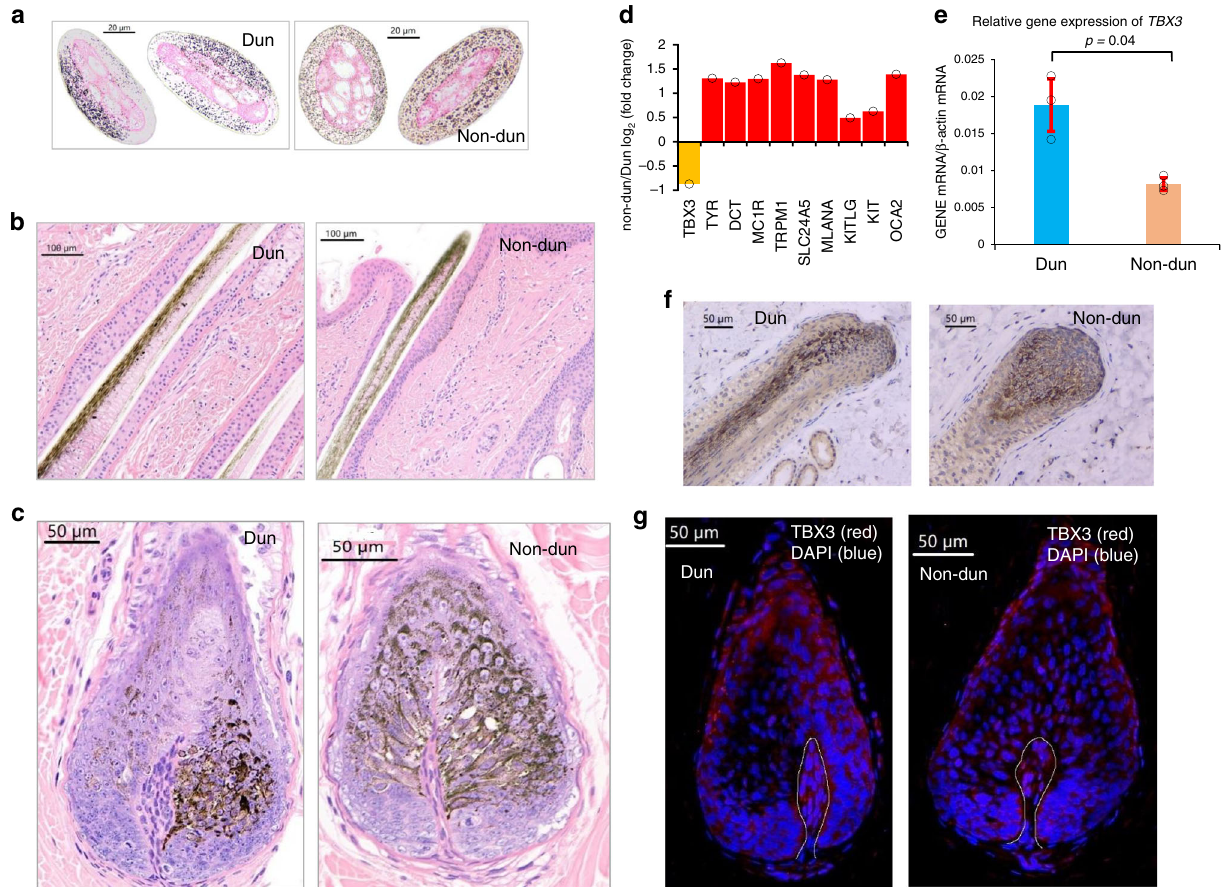
Fig. 4 Phenotypic characterization and differential gene and protein expression in the croup skin of Dun and non-Dun donkeys. a Micrographs of cross- sections of hairs from Dun and non-Dun donkeys, images representative of three experiments b Micrographs of skin and hair sections from Dun and non- Dun donkeys stained with hematoxylin and eosin, images representative of three experiments. c Micrographs of sections of anagen hair follicles from Dun and non-Dun donkeys stained with hematoxylin and eosin, images representative of three experiments. d Bar plot of differential mRNA expression (log 2 - transformed fold change) of 10 pigmentation-related genes expressed in the skin of non-Dun ( n = 3) versus Dun ( n = 3) donkeys. Upregulated and downregulated genes are indicated with red and orange bars, respectively. Black circles indicate the data points. e Relative croup skin TBX3 mRNA levels (mean ± s.e.m.) as assessed by quantitative RT-PCR in Dun ( n = 3) and non-Dun ( n = 3) donkeys (statistical signi fi cance of a two-tailed t -test is indicated). Black circles indicate the data points. Source data are provided as a Source Data fi le. f Micrographs of immunohistochemistry of the TBX3 protein in sections of hair follicles from the croup of Dun and non-Dun donkeys, images representative of three experiments. g Micrographs of immuno fl uorescence analysis of the TBX3 protein (red) in sections of anagen hair follicles from the croup of Dun and non-Dun donkeys, images representative of three experiments. DAPI staining is indicated with blue color, and white lines show the basement membrane. Scale bars were de fi ned in each